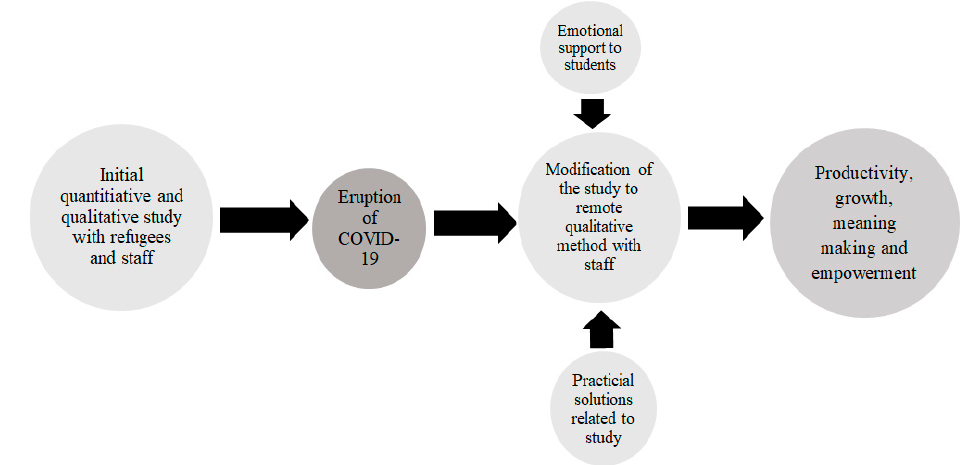
Figure 1. Challenges of researchers in conducting international study during the eruption of COVID-19.